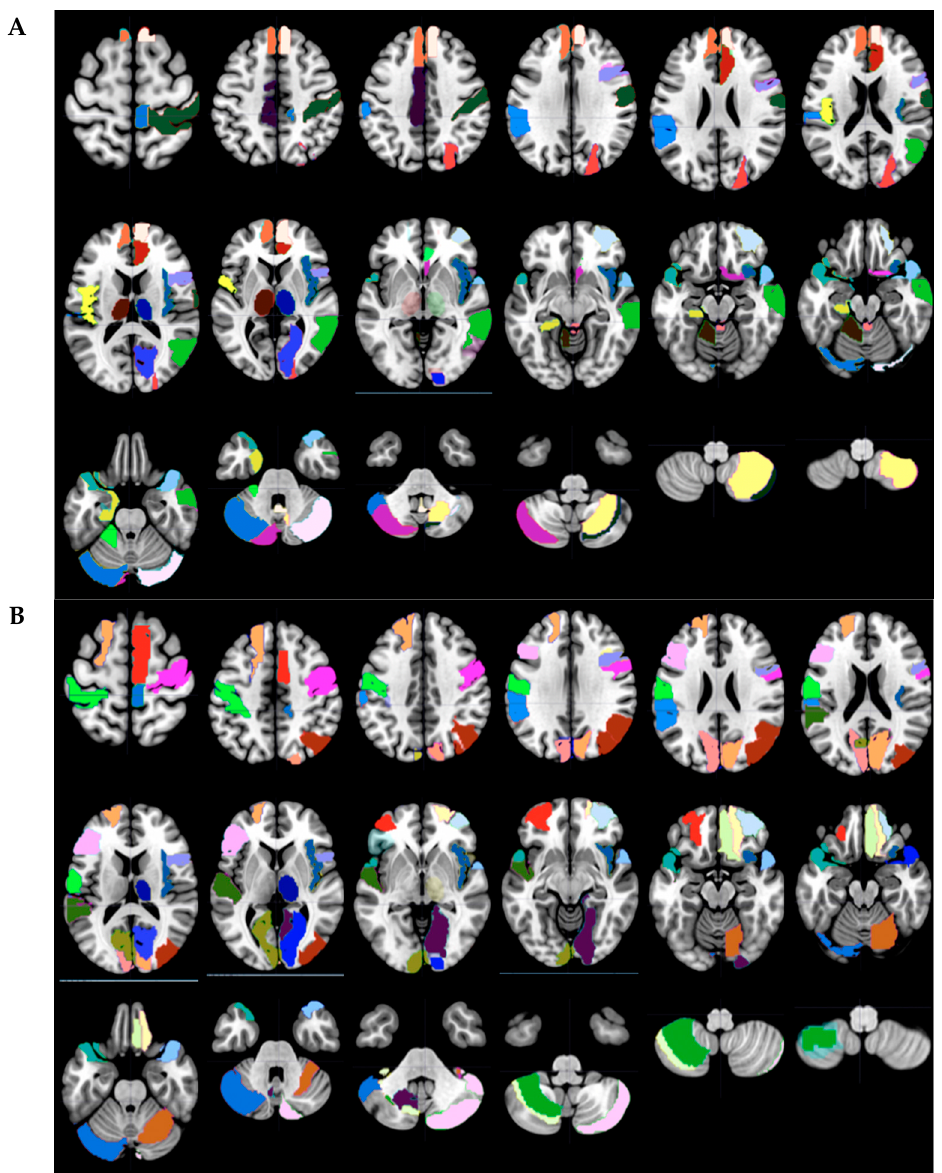
Figure 3. Automated Anatomical Labeling (AAL) regions that distinguished GWI from control subjects on the Day 1 and 2 logistic regression models. Axial slices (left side on left of each slice) were shown for ( A ) Day 1: Pre-Submaximal Exercise Comparison of N-Back > 0-Back test between GWI and Sedentary Control and ( B ) Day 2: Post Submaximal Exercise Comparison of N-Back > 0-Back test between GWI and Sedentary Control. Ten AAL regions that were in both the Day 1 and Day 2 logistic models were colored dark blue (see SOM Table S1 and Figure S1 for detailed descriptions of each region) and included the right frontal pole, left and right temporal poles, right insula, right thalamus and cerebellar lobules. The other colors have no specific significance. ( A ) Nineteen additional regions differentiated GWI from control on Day 1, and included right superior frontal, bilateral orbital frontal, left dorsolateral prefrontal, left parietal, and visual regions. (B) Eighteen additional regions were identified on Day 2 and included medial frontal gyri in the frontal pole, left middle cingulate, left thalamus, right occipital and temporal regions, and cerebellar regions.